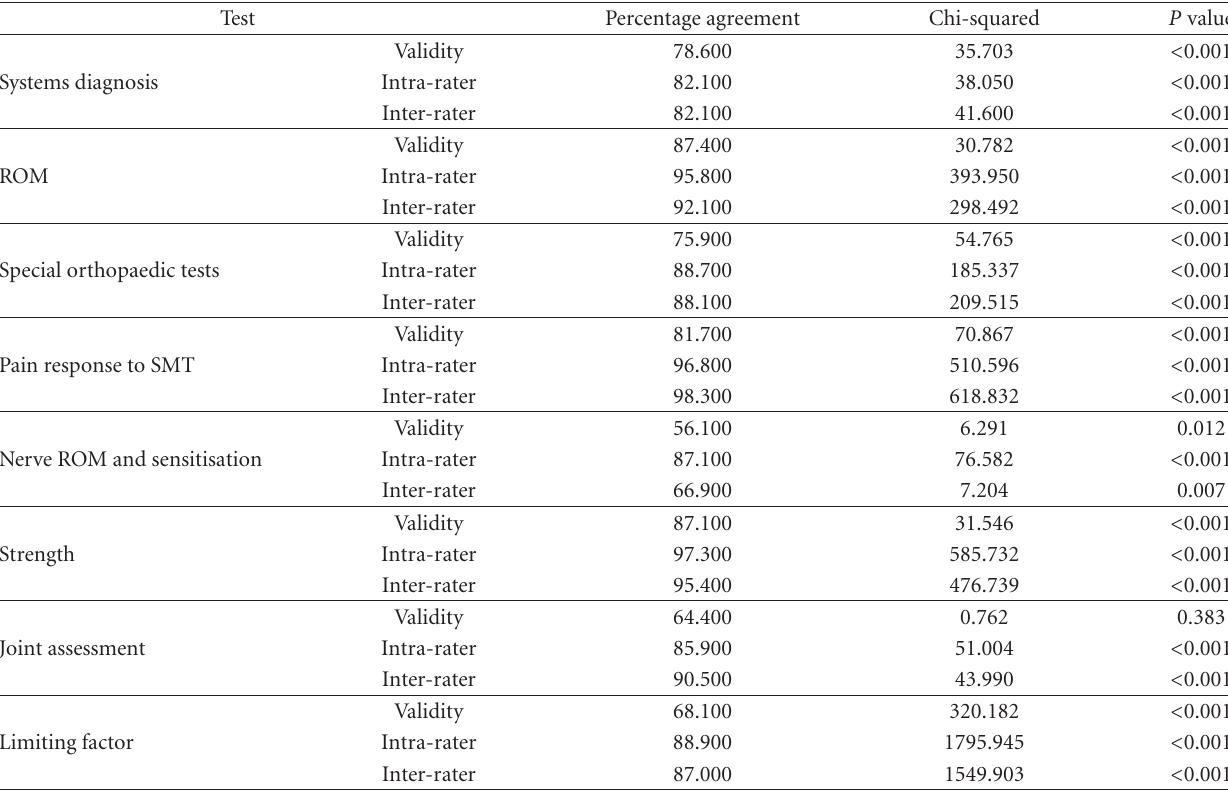
Table 4: Results from the analysis of physical examinations producing binary data.